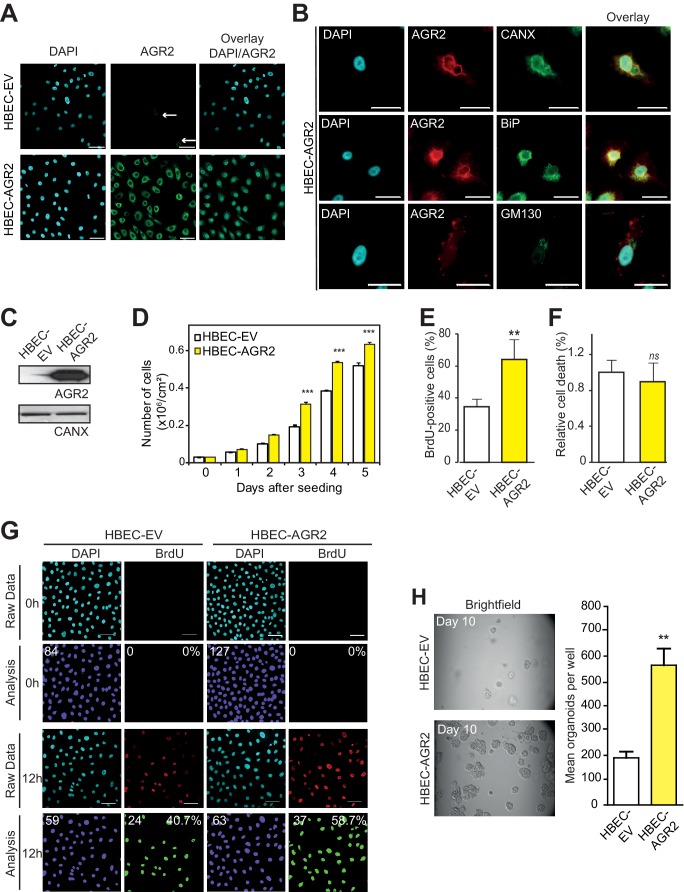
Enhanced cell proliferation and transformation after AGR2 overexpression in HBECs.(A) Analysis by immunofluorescence of AGR2 overexpression in HBECs. Scale bars, 50 μm. (B) Analysis of AGR2 sub-cellular localization in infected HEBCs by immunofluorescence. Calnexin (CANX) and Bip (GRP78) are used as an ER localization control and GM130 is used as a Golgi localization control. Scale bars, 50 μm. (C) Up-regulation of AGR2 protein concentrations in control cells (HBEC-EV) and in cells infected with AGR2 (HBEC-AGR2), as analyzed by western blot. Calnexin (CANX) concentrations are shown as the loading control. One representative experiment (n = 3) is shown. (D) Growth of cells stably expressing AGR2 or empty vector (EV) (three independent experiments). Data are mean ± SEM. (E) Quantification of the percentage of BrdU positive cells. Data are presented as mean ± SEM of at least three independent experiments. **p<0.001. (F) Quantitation of cell death in AGR2 overexpression cells. Results are representative of three independent experiments. The cell death rate was determined by Trypan blue dye-exclusion assay. n.s: not significant. (G) Cell proliferation on HBEC overexpressing AGR2 cells. Representative images of control HBECs (HBEC-EV) and HBEC-AGR2 stained for BrdU (red) administrated 12 hr before, and with DAPI (blue). Images were subjected to high throughput imaging (bottom panels, analysis data). After acquisition of the dataset, images were segmented by a watershed transformation to identify individual cells (bottom right). Scale bars: 100 μm. (H) The bar graph shows the mean of organoids per well (mean ± SEM.) after 10 days of culture from three independent experiments. Shown at the left are representative images of the organoids formed by each type of cell HBEC-AGR2 and HBEC-empty vector. The p values (determined by Student's t test) are relative to empty vector infected cells. **p≤0.01 and ***p≤0.001.